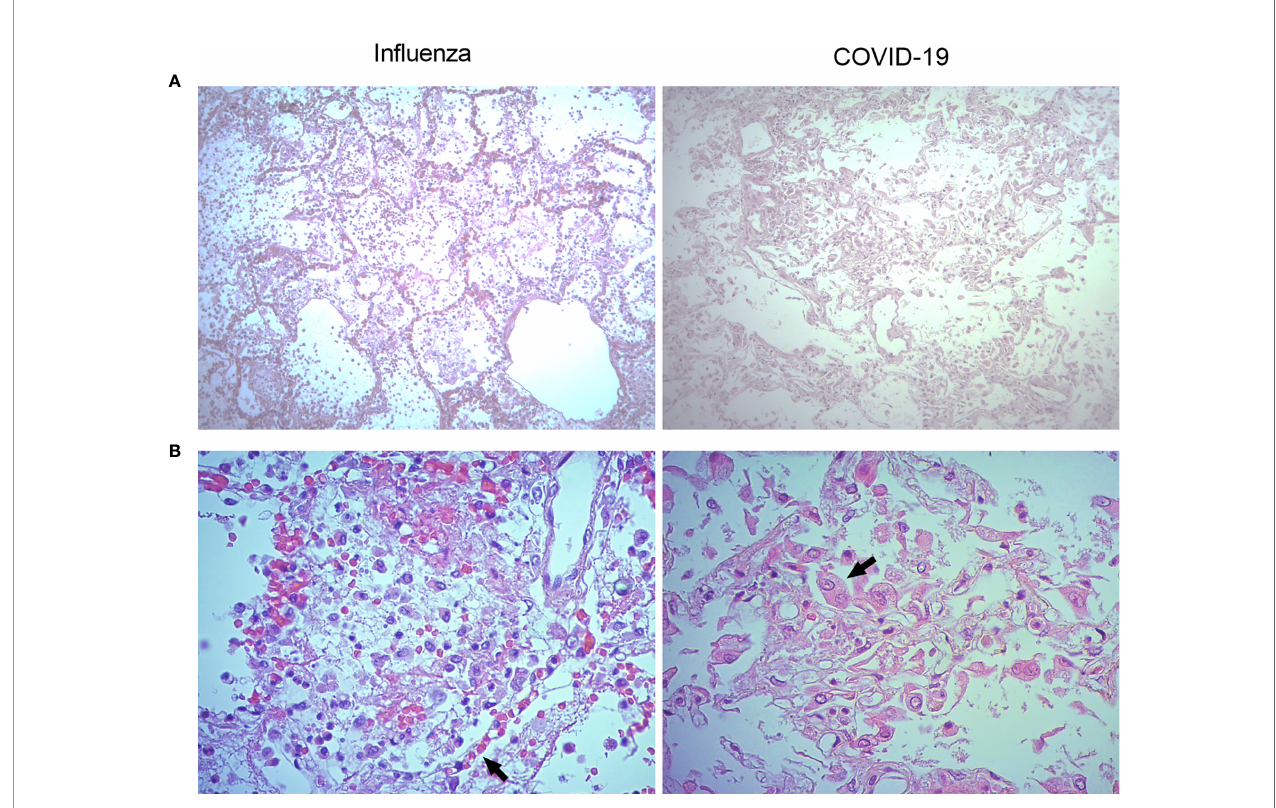
FIGURE 2 | Histological characteristics of the lungs of patients with pandemic in fl uenza A(H1N1) and COVID-19. Lung tissue autopsy specimens were obtained from patients that died of pandemic in fl uenza A(H1N1) and COVID-19. (A) The histological changes induced in the lungs during pandemic in fl uenza A(H1N1) were mainly characterized by intra-alveolar in fl ammatory in fi ltrates that did not compromise the integrity of alveolar walls (left panel). Meanwhile, the morphological changes of COVID-19 consisted of extensive in fl ammation, thickening of the alveolar walls, and partial loss of the histological architecture (right panel). H&E staining, x100. (B) The in fl ammatory in fi ltrates observed in the lungs of pandemic in fl uenza A(H1N1) patients consisted of macrophages, polymorphonuclear cells, and scarce lymphocytes scattered between areas of edema, hemorrhage, and fi brin deposits. Also, congestive, and vasodilated capillaries (arrow) were observed in the alveolar walls of in fl uenza patients (left panel). Conversely, the in fl ammatory in fi ltrates found in the lung of COVID-19 patients were dominated by macrophages. Furthermore, the detachment of alveolar epithelial cells, which showed atypical characteristics such as large nucleoli (arrow), was also notable in COVID-19 patients (right panel). H&E staining,